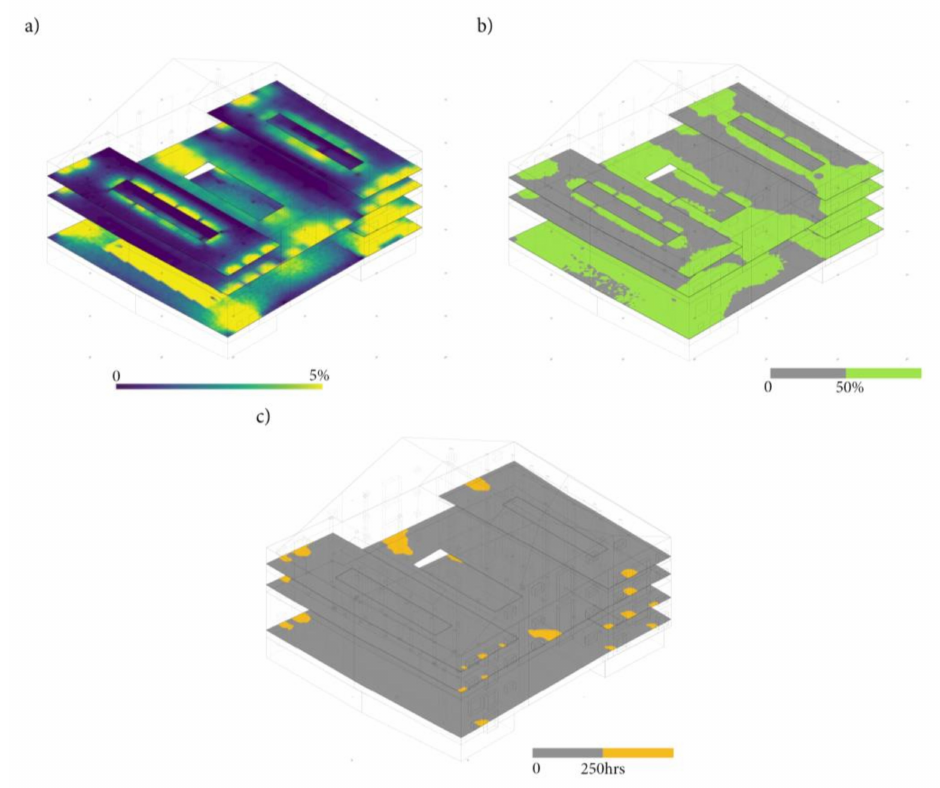
Figure 11. Simulation results in the optimized Scenario; ( a ) DF; ( b ) sDA 300,50% ; ( c ) ASE 1000,250